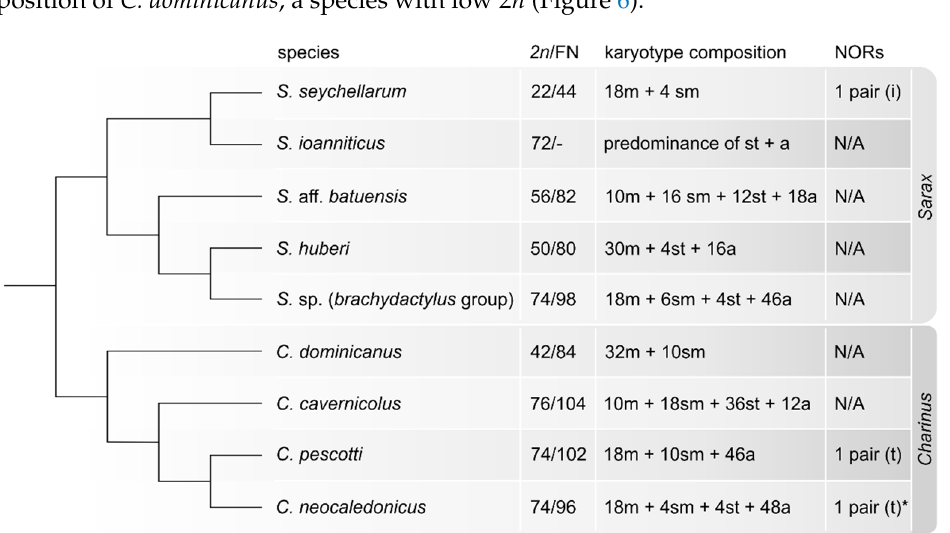
Figure 6. Charinidae, karyotype features, including number and position of NOR loci. Mapped on a cladogram constructed based on the recent molecular phylogeny of Miranda et al. [10]. Abbreviations: a = acrocentric chromosome, FN = fundamental number, m = metacentric chromosome, N/A = not analyzed, I = interstitial position, NORs = distribution of nucleolar organizer regions, sm = submetacentric chromosome, st = subtelocentric chromosome, t = terminal position. * In C. neocaledonicus , the NOR distribution has been assessed by both silver staining and rDNA FISH techniques. On the contrary, in two remaining species, only rDNA FISH has been carried out. We did not include the karyotype data of Millot and Tuzet [16] on Sarax sarawakensis. The authors indicated 2 n = 25 for males, including a single X chromosome (the sex chromosome system ♂ X0/ ♀ XX). The graphical documentation of results presented by these authors is not sufficient to support their state- ments.